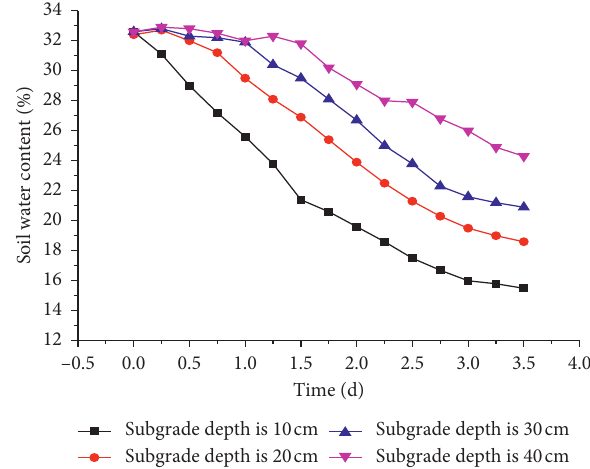
Figure 15: Relationship between soil water content and time at different soil